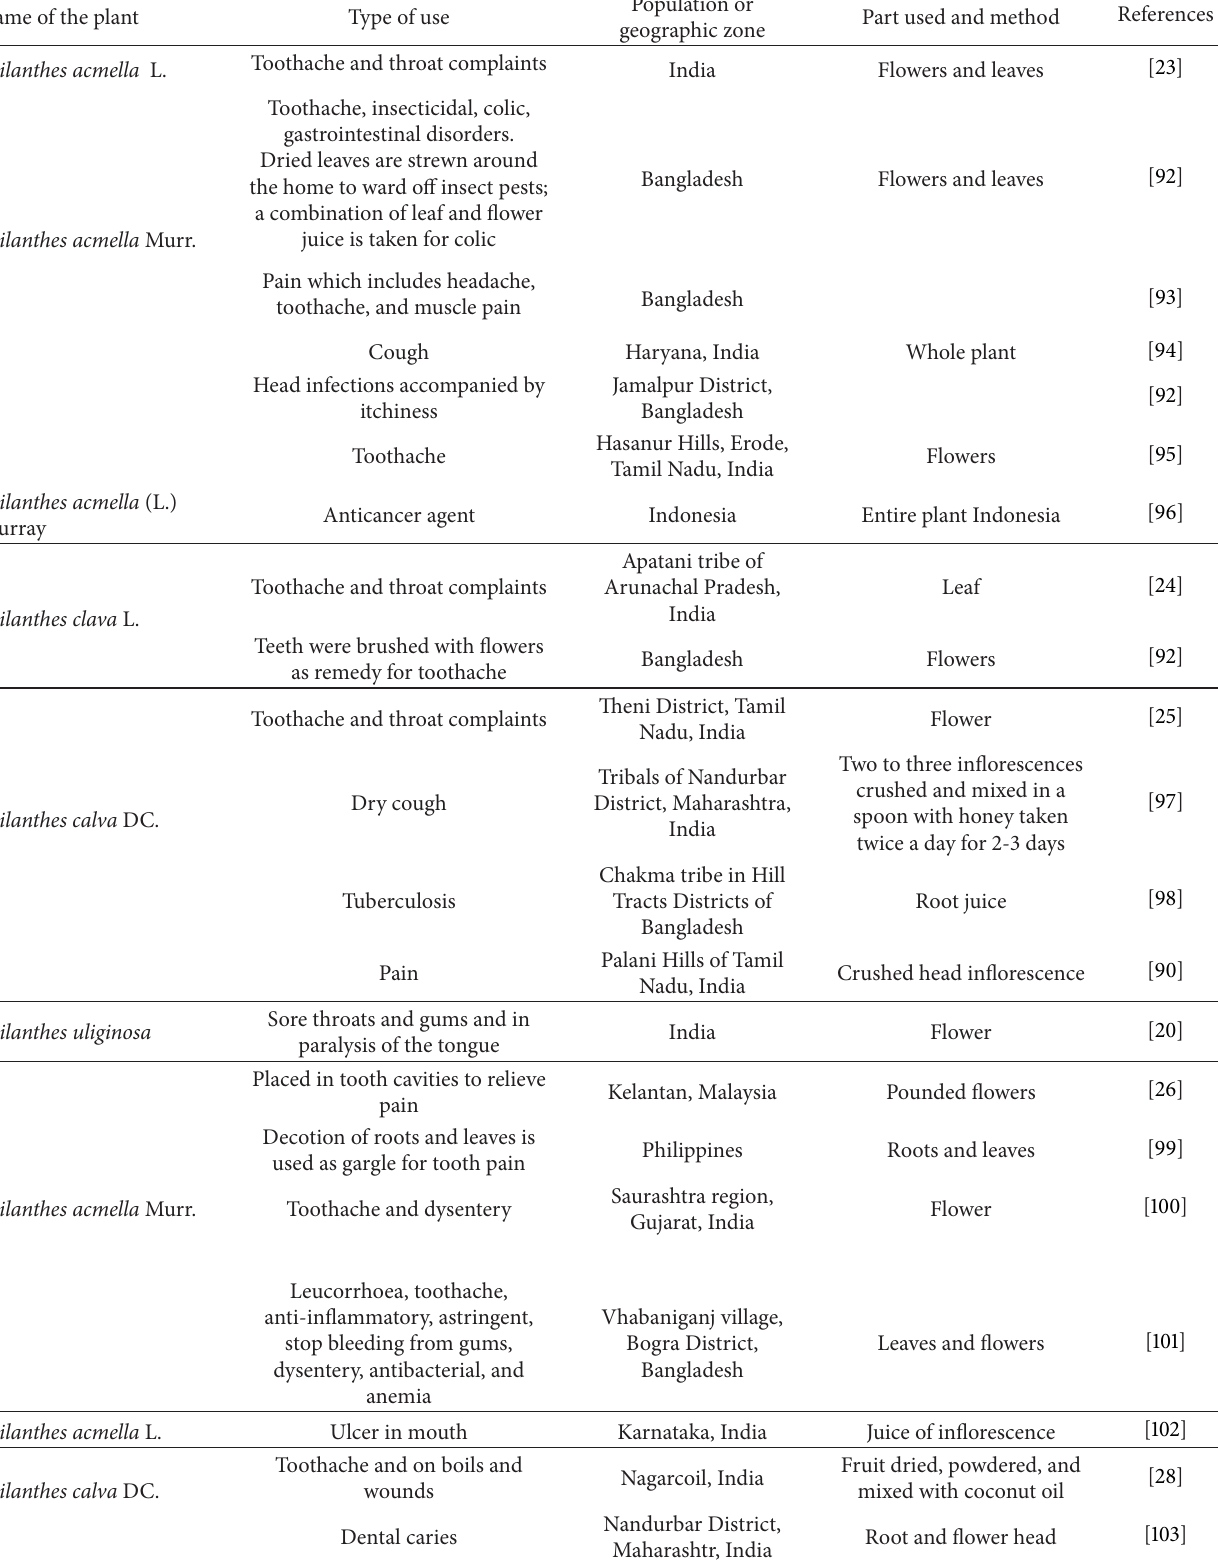
Table 1: Reported uses of genus Spilanthes in ethnopharmacological